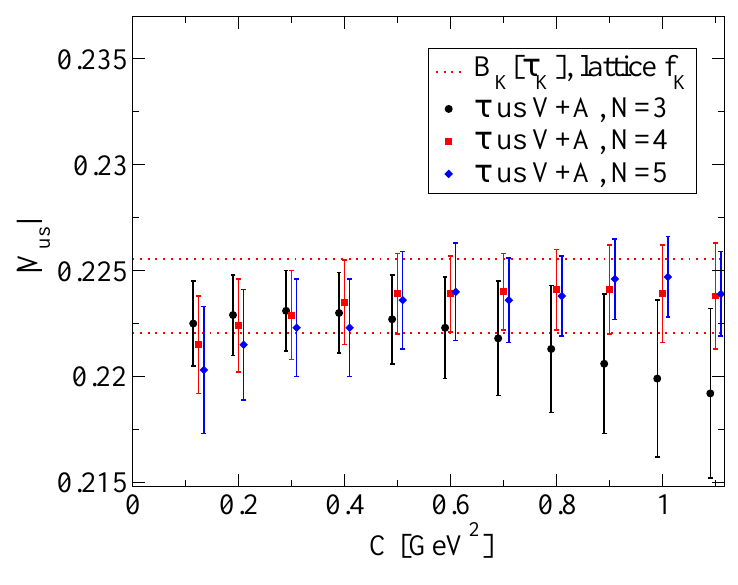
| as a function of C for N = 3 , 4 and 5 . The Figure 3: Lattice-based results for | V us | obtained using the measured dashed lines show, for comparison, the bounds on | V us single-prong τ BF B together with the RBC / UKQCD lattice result for f K K